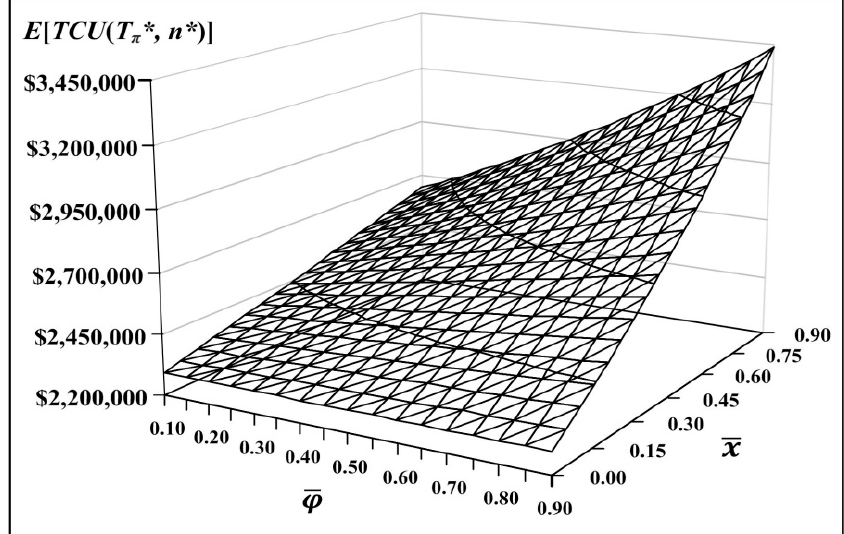
Figure 13. Joint impacts of changes in 𝜑(cid:3364) and 𝜋(cid:3364) on E [ TCU ( T π *, n *)].